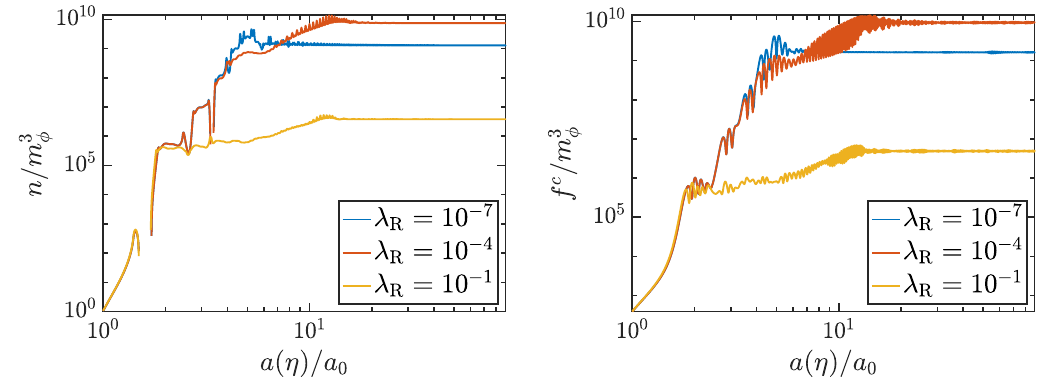
Figure 4 . The integrated comoving particle number density n (left panel) and the integrated absolute value of the coherence functions f c (right panel) for λ R ∈ { 10 − 7 , 10 − 4 , 10 − 1 } with ¯ ξ R = 50 and Γ = 0 .